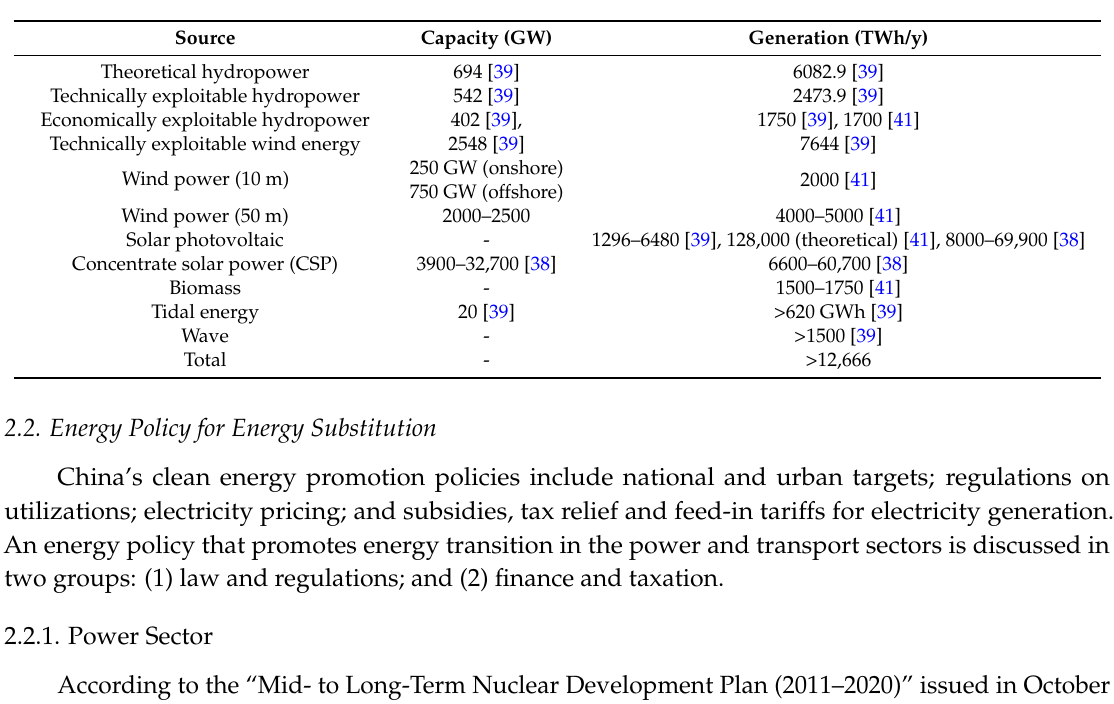
Table 2. Renewable energy